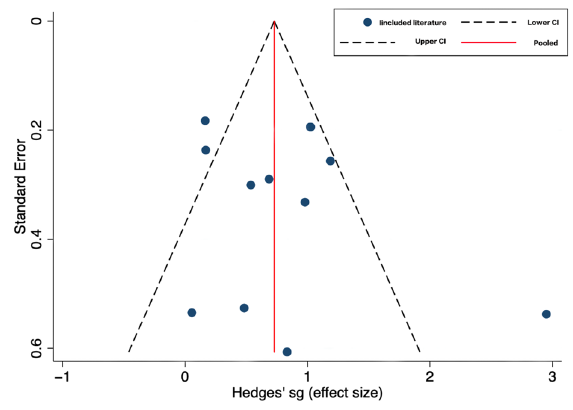
Figure 4. Funnel